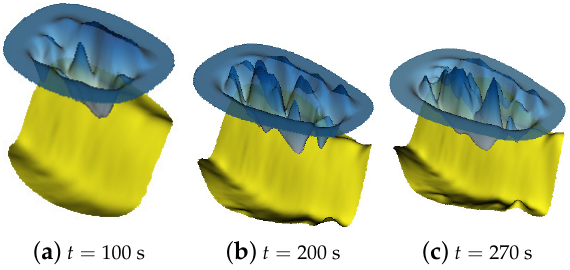
Figure 19. Active generation: the bottom and the free surface elevation computed with the domain adaptivity